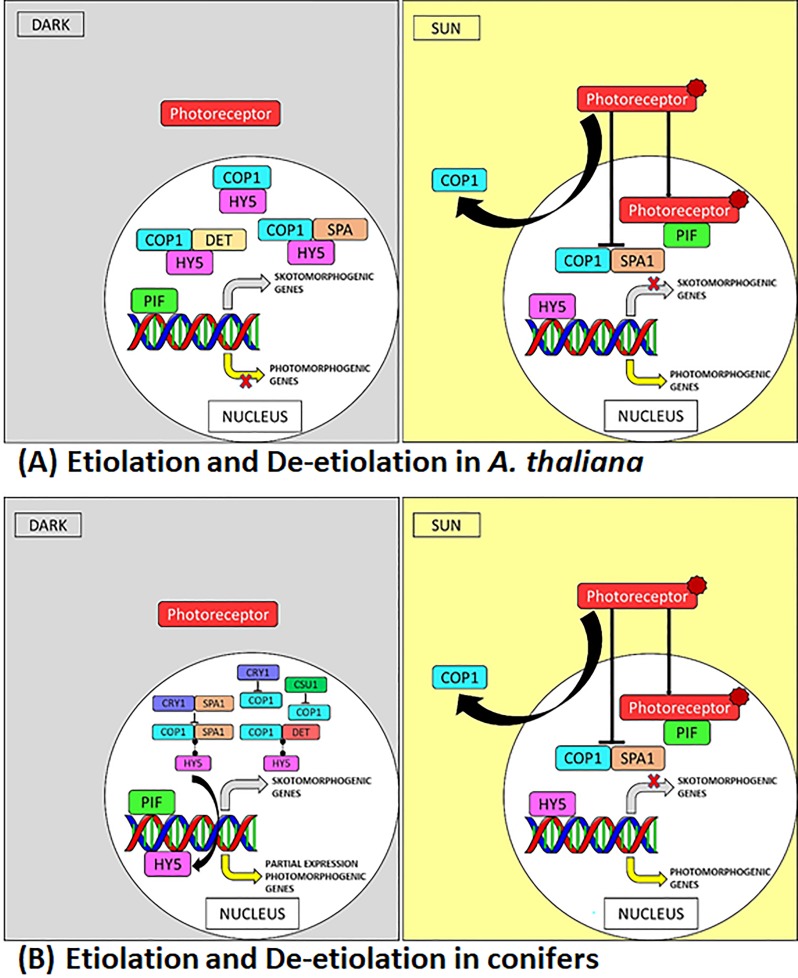
Comparison of the process of etiolation and de-etiolation in A. thaliana and conifers.(A) Etiolation and de-etiolation in A. thaliana (B) Proposed mechanism for etiolation and de-etiolation in conifers.